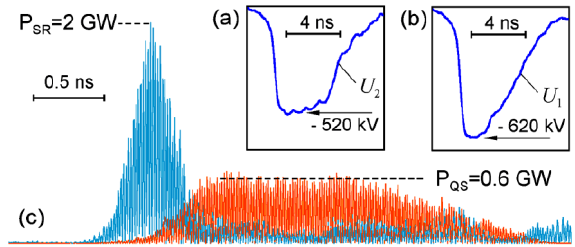
Fig. 1. (a, b) Voltage pulses fed e-beams with power of 2 GW and 3 GW, respectively. (c) Time referenced SR and QS pulses formed by BWOs in the case of the voltage (a) One can see (Fig. 2) that SR oscillator demonstrates a fewer phase spread as compared to QS BWO. Apparent- ly, this is the result of shortened “transient” time for a single-pass amplification of a seed EM signal by SR me- chanism (Fig. 1, b) when initial current perturbation does not include information about the further voltage pulse form and/or its amplitude deviations. Besides, delayed